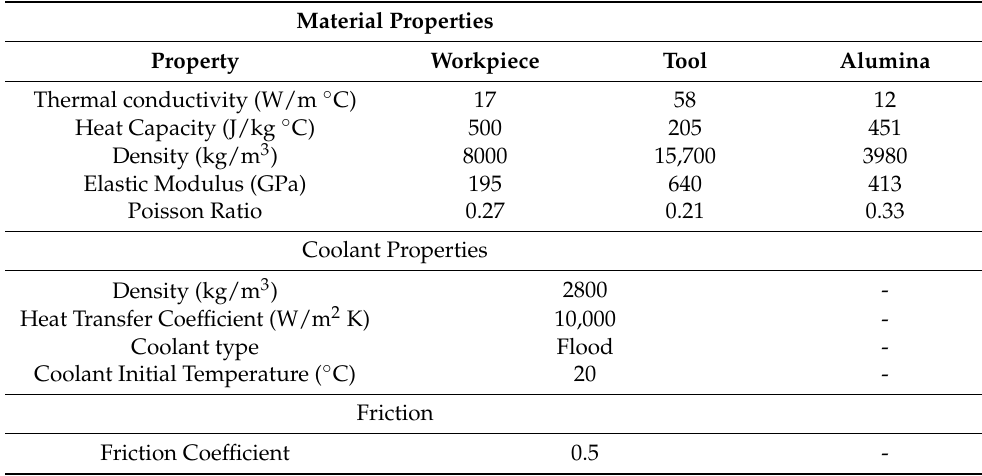
Table 1. Materials properties and contact